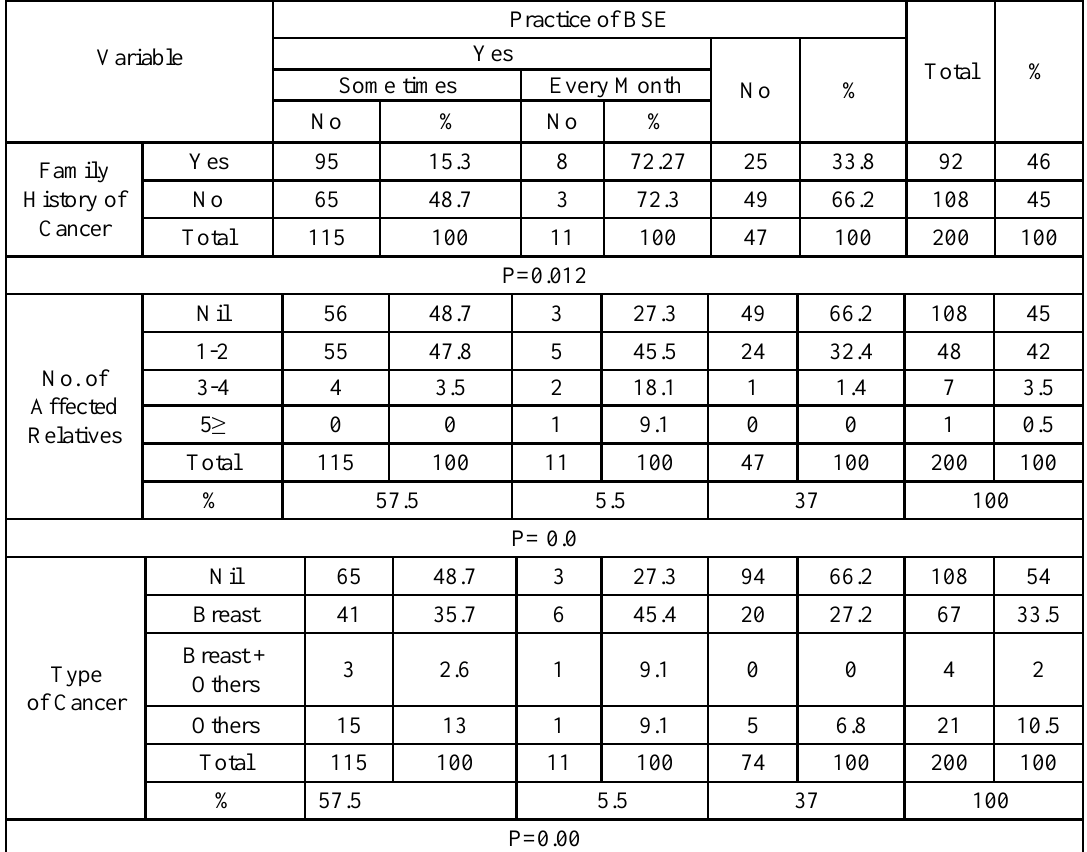
Table (2): Correlation of the family history of cancer with the practice of BSE.